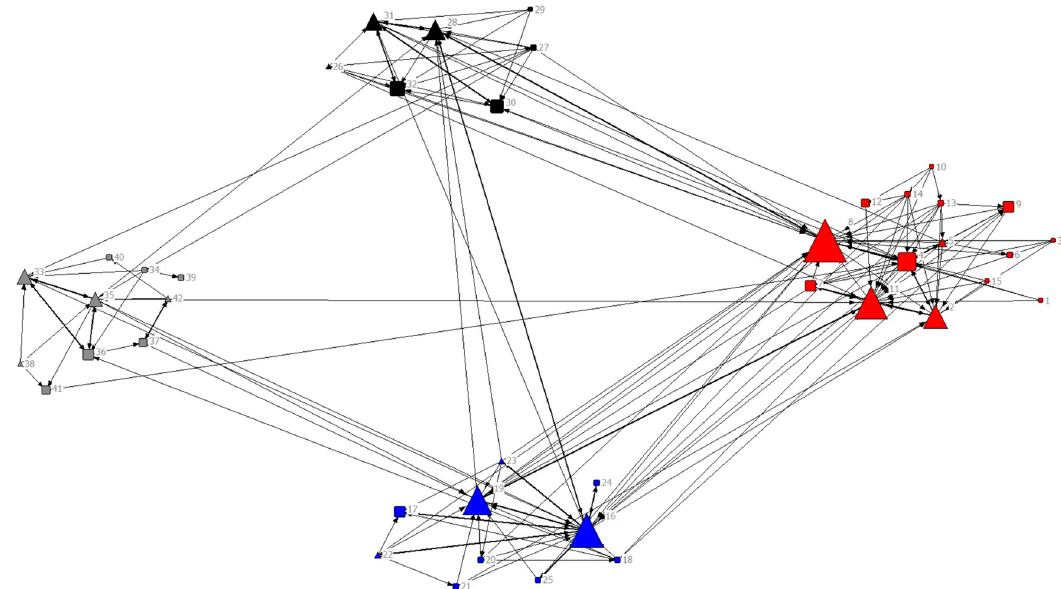
Fig 3. Sociogram of the advice-seeking ties. Nodes are agroforestry farmers, and ties are the relationship to seek agroforestry advice, with the arrow pointing at the person with whom they sought advice. Node colours represent farmers’ village affiliation (village A–site of early agroforestry introduction in red, village B–site of early agroforestry introduction in blue, village C–site of middle agroforestry introduction in black, and village D–site of late agroforestry introduction in grey). The node shape represents farmers’ leadership status (farmer leaders in triangles and general members in squares). The node size represents in-degree centrality, with size proportional to the value. Thicker width in edges or lines indicates reciprocated ties.